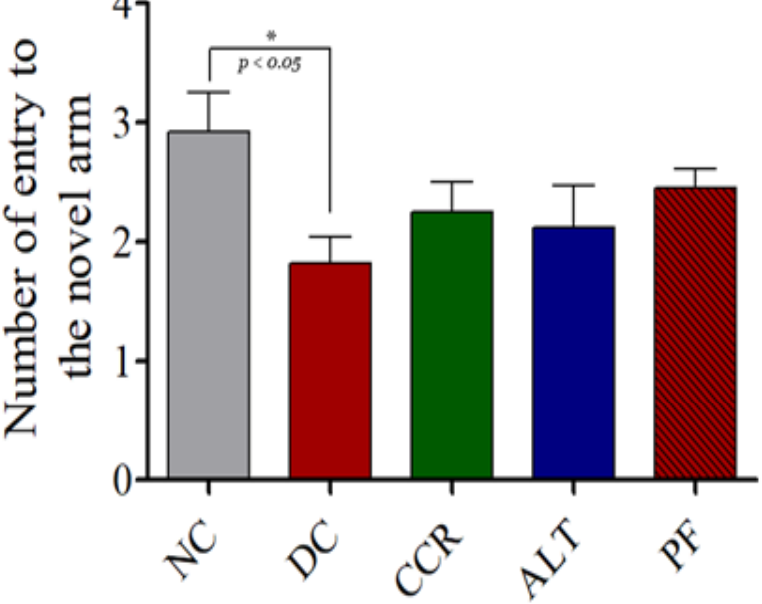
Figure 3. Effects of various intermittent fasting protocols on the number of entries into the novel arm of the Y-maze. The results revealed that the number of entries into the novel arm were significantly lower in the DC group compared to the control group, but not significantly lower in the CCR, ALT, or PF groups compared to the control group (* p < 0.05). Data are expressed as the mean ± standard error of the mean. NC = Control, DC = Diabetes, CCR = Continuous calorie restriction, ALT = Alternate day calorie restriction, PF = Calorie restriction for 2 days.